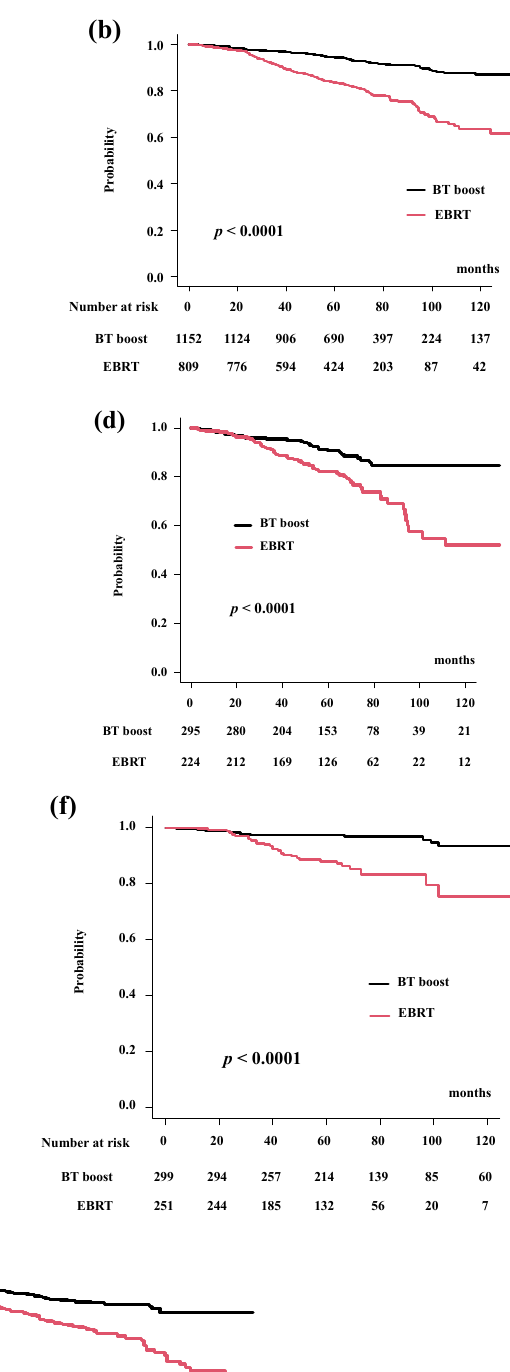
5 of 14 3. Results 3.1. Patient and Disease Characteristics All 1961 patients with intermediate-to-high-risk prostate cancer were treated with either BT-boost ( n = 1152) or EBRT ( n = 809). The median patient age was 71 years (range, 49–89 years). The median initial PSA value was 14.0 ng/mL (range, 2.682–1454 ng/mL). The clinical characteristics of the patients are summarized in Table 1. The median follow-